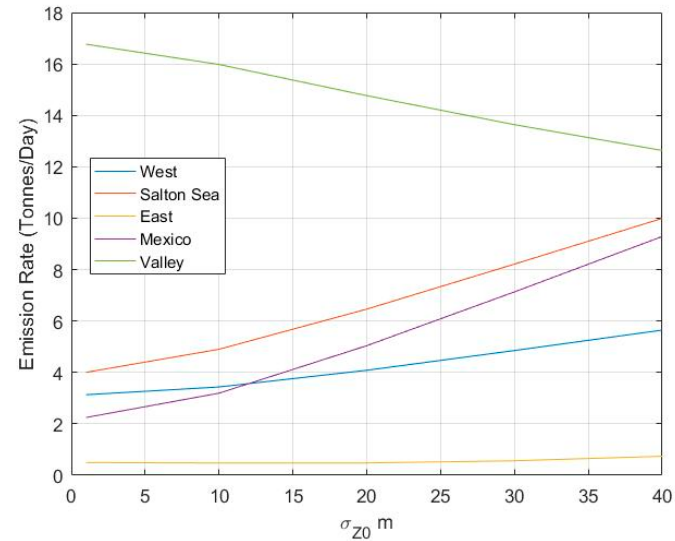
Figure 10. Model determined annual emission rates of different sources versus different prescribed inputs of initial plume spread ( σ z0 ).